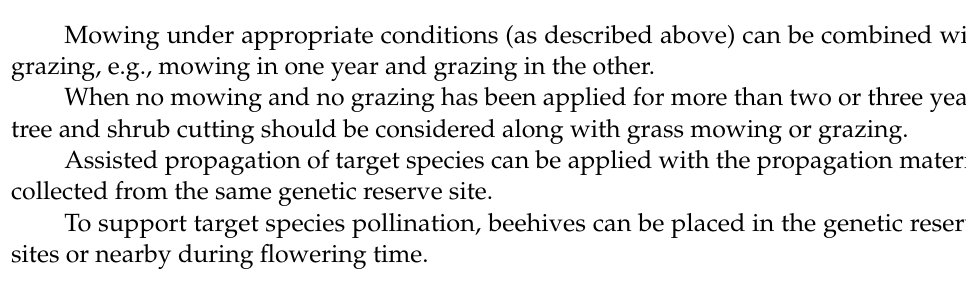
Figure 1. Structure and functioning scheme of maintenance interventions in genetic reserve sites of medicinal plants.